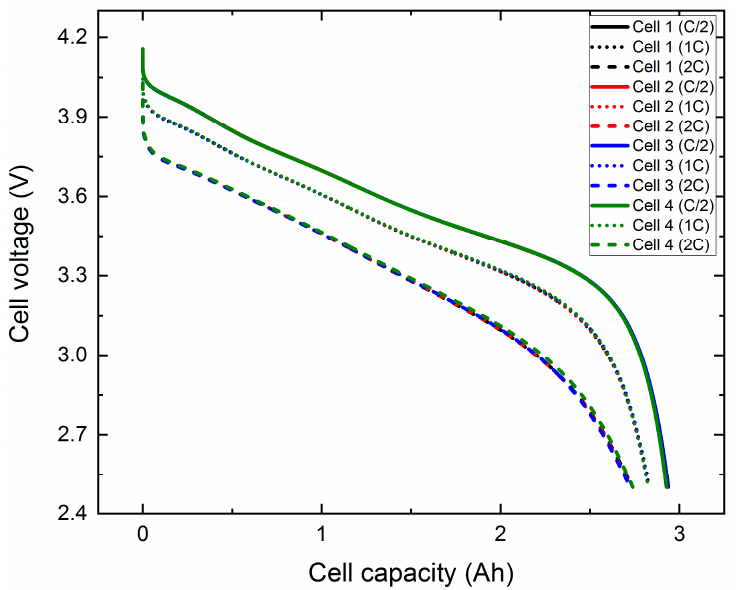
Figure 3. Cell voltage versus capacity of individual cells during discharge with rates of C/2, 1C and 2C, measured at room temperature of 20 °C.